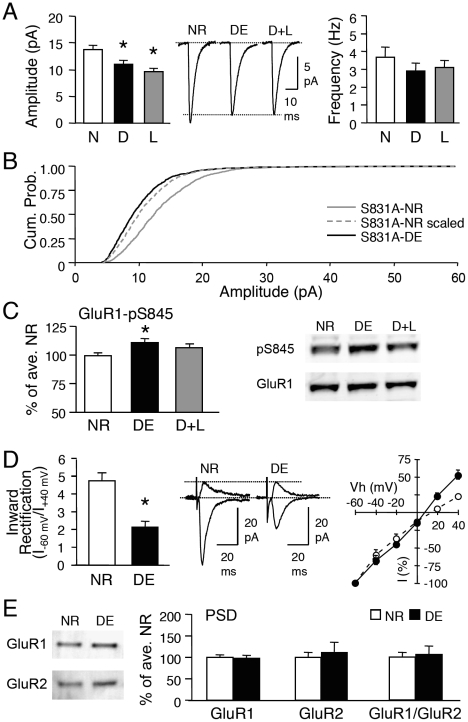
Abnormal visual experience-induced homeostatic synaptic plasticity in GluR1-S831A mutants.
(A) Left: average mEPSC amplitude decreased with dark-exposure (D) and did not decrease any further with re-exposure to light (L). *: Significantly different from NR (N) at p<0.01, Fisher's PLSD posthoc test. Middle: average mEPSC traces from each group. Right: No significant changes in mEPSC frequency across groups. (B) Dark-exposed GluR1-S831A mutants displayed smaller mEPSC amplitudes as seen as a leftward shift in the cumulative probability curve of S831A-DE (black solid line) compared to S831A-NR (gray solid line). To determine whether this is due to multiplicative scaling down of mEPSCs, we multiplied the mEPSC amplitude of S831A-NR with a scaling factor (0.8) to match the average mEPSC amplitude of S831A-DE (S831A-NR scaled, gray dotted line). The cumulative probability curve of S831A-NR scaled did not match that of S831A-DE (p<0.01, Kolmogrov-Smirnov test) suggesting that the decrease in mEPSC size does not follow the rules of multiplicative scaling. (C) Left: GluR1-S831A mutants showed a normal increase in the remaining GluR1-S845 phosphorylation with DE. *: p<0.01, Fisher's PLSD posthoc test. Right: example immunoblots probed simultaneously with pS845 antibody (upper) and GluR1 C-terminal antibody (lower). (D) Left: dark-exposure (DE) GluR1-S831A mutants significantly reduced the inward rectification index. *: p<0.001, t-test. Middle: superimposed representative traces of evoked AMPAR-EPSC for NR and DE taken at −60 mV and +40 mV. Right: DE S831A mutants (black circles) show a more linear I-V curve than NR S831A mutants (open circles). (E) No change in GluR1 (left), GluR2 (middle), or GluR1/GluR2 ratio (right) in the PSD samples of NR and DE S831A mutants.